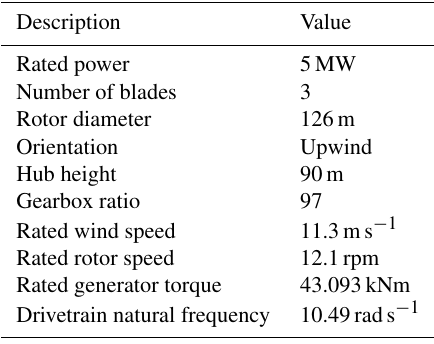
Table 1. NREL 5MW wind turbine description (Bossanyi and Witcher,